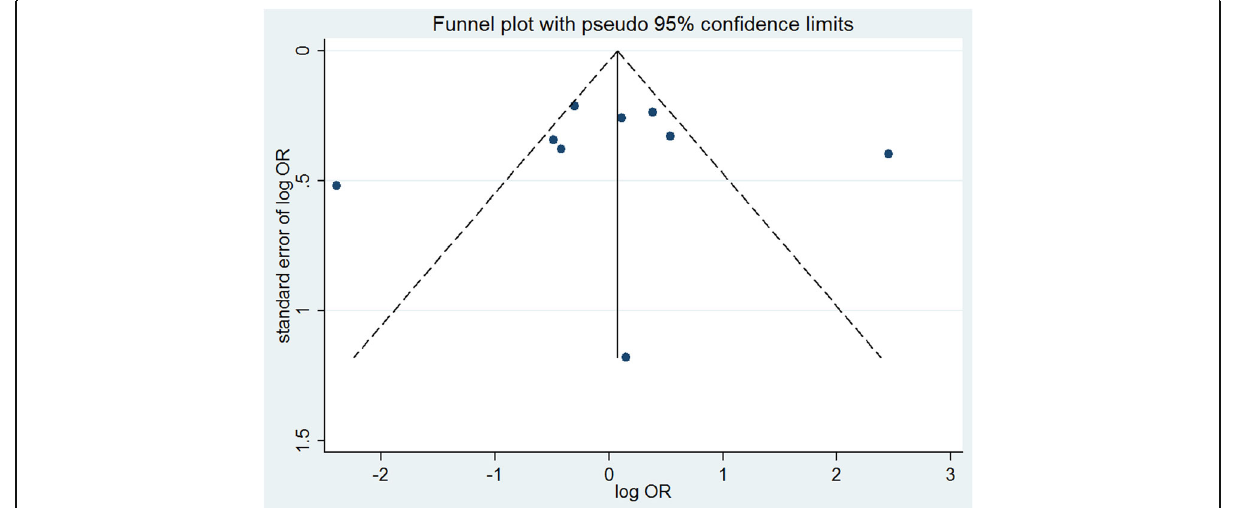
Fig. 3 Funnel plot for evaluation of publication bias in breast